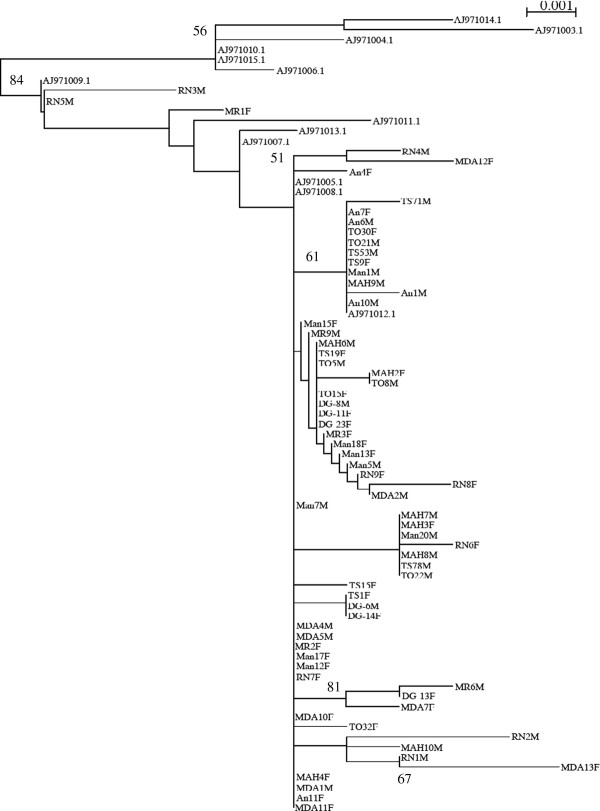
Phylogeny inference from concatenated COI and ND5 genes of Aedes albopictus by the maximum likelihood (ML) method based on the general time reversible (GTR) model. Percentage bootstrap supports (1000 replicates) superior to 50% are given at each node. Branch lengths represent estimated substitutions per site. Code sequence is as follows: An (Ankazobe), DG (Diego-Suarez), MAH (Mahajanga), Man (Mananjary), MDA (Montagne d'Ambre), MR (Morondava), RN (La Réunion), TO (Toamasina), TS (Tsimbazaza). Sequences retrieved from Genbank belonged to specimens from Brasil (AJ971003.1 and AJ971014.1), Vietnam (AJ971004.1 and AJ971010.1), Thailand (AJ971015.1), Cambodia (AJ971006.1), France (AJ971009.1 and AJ971008.1), Hawai (AJ971011.1), USA (AJ971005.1), La Reunion (AJ971013.1 and AJ971012.1), and Madagascar (AJ971007.1).